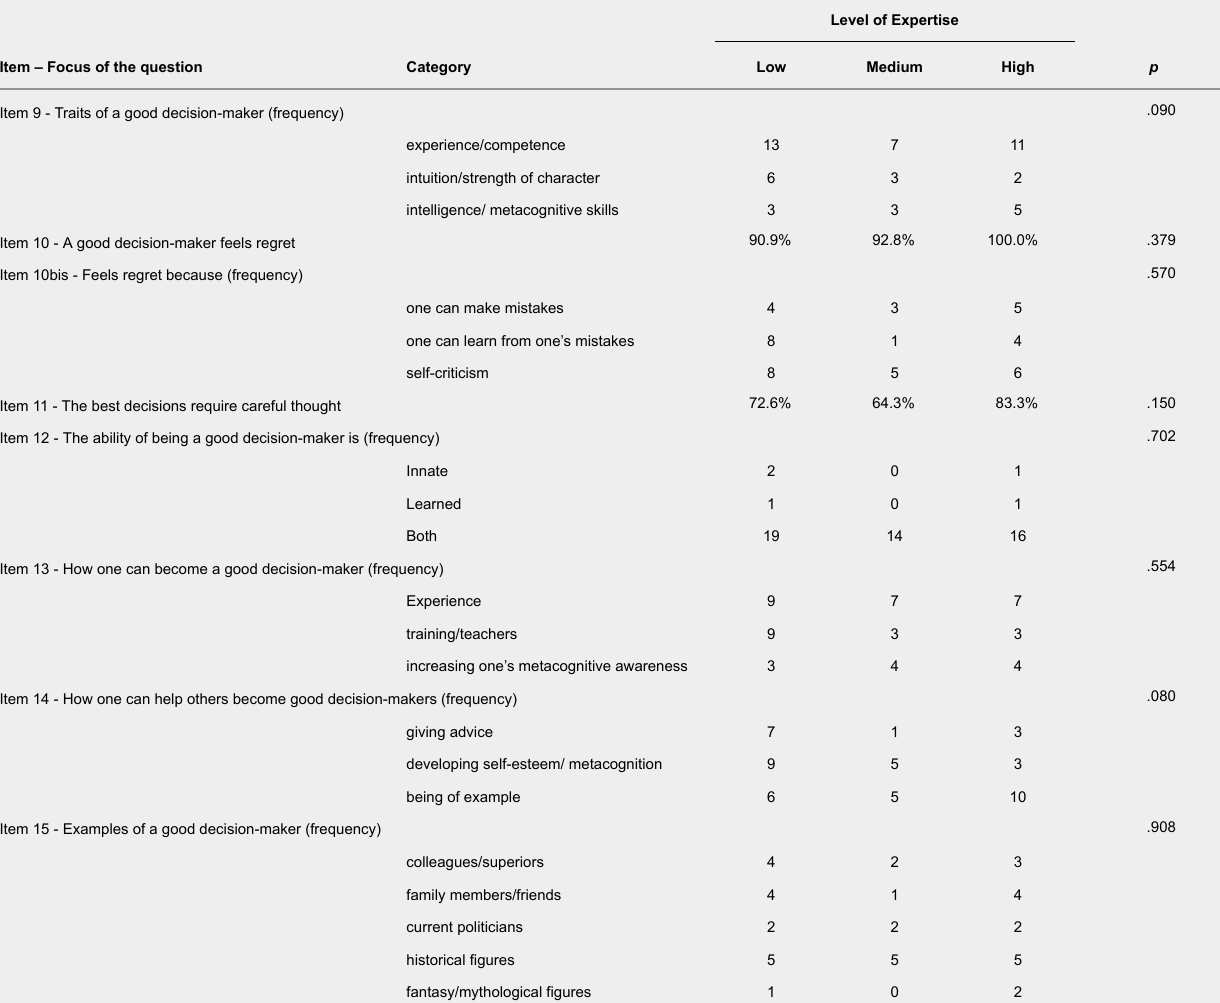
Responses to Questions in the Second Part of the Questionnaire, Grouped by Level of